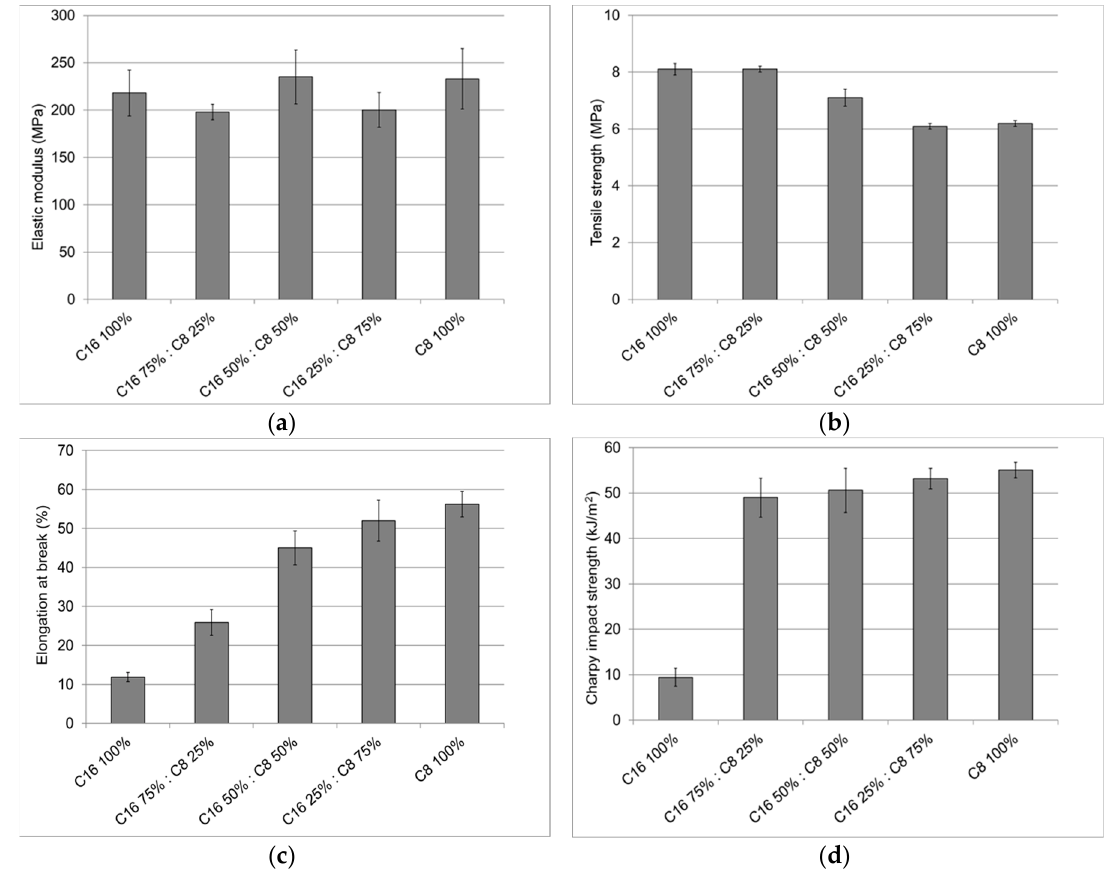
Figure 3. Mechanical properties of injection-molded cellulose C8 and C16 ester samples and their mixed blends: ( a ) Elastic modulus; ( b ) tensile strength; ( c ) elongation at break; ( d ) Charpy impact strength.